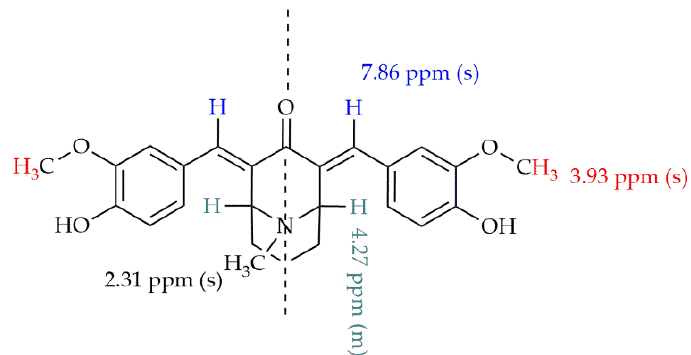
Int. J. Mol. Sci. 2021 , 22 , x FOR PEER REVIEW Figure 1. Characteristic signals on the 1 H NMR spectrum of compound 13 . Figure 1. Characteristic signals on the